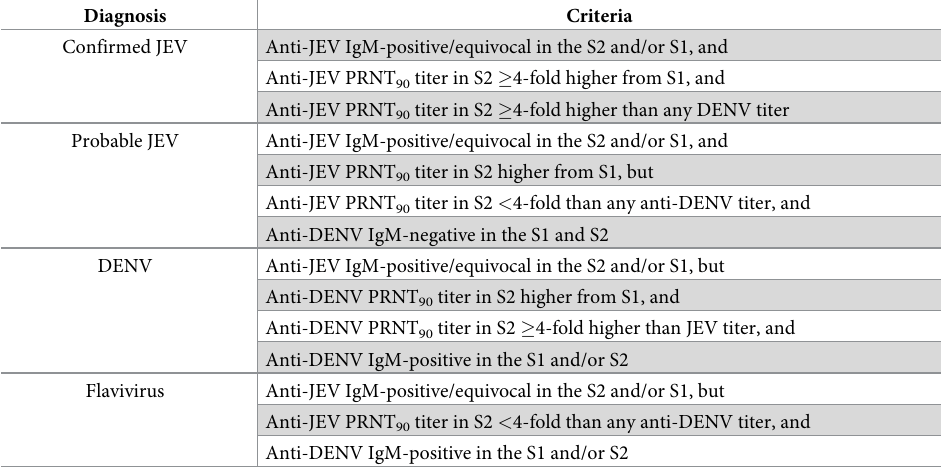
Table 1. Diagnostic interpretation of the serology testing